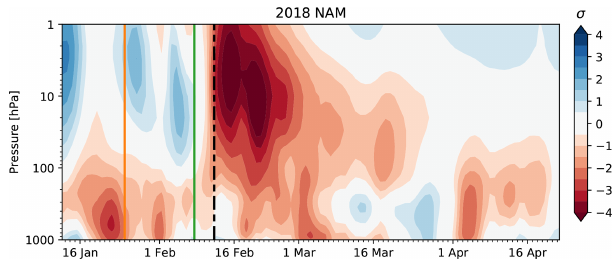
Figure 5. NAM indices during the February 2018 boreal major warming. The NAM indices are computed from ERA5 geopotential height anomalies following the methodology of Gerber and Mar- tineau (2018). The vertical dashed–dotted black line indicates the date of the wind reversal at 10hPa, 60 ◦ N. The vertical green and orange lines indicate the requested initialization dates.